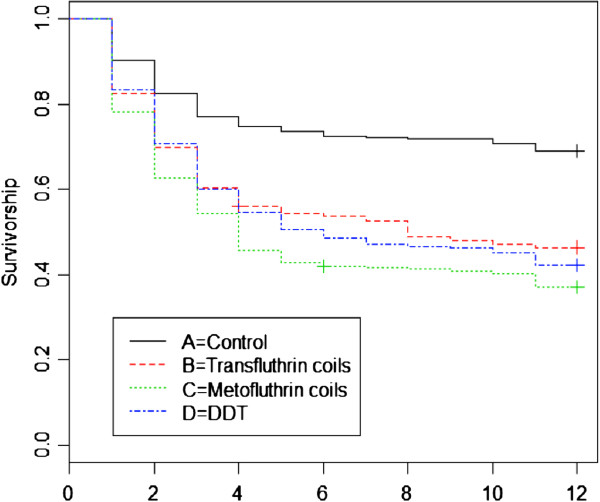
Survival curves illustrating the rate at which mosquitoes left huts with DDT, transfluthrin and metofluthrin coils. The curves represent the rate at which mosquitoes exit huts that have different insecticides compared to the control. Time (hours) to which mosquitoes left huts: 1–2100, 2–2200, 3–2300, 4–0000, 5–0100, 6–0200, 7–0300, 8–0400, 9–0500, 10–0600, 11–0700. Analysis was based on a Kaplan-Meier stepped survivorship function. Each curve represents one treatment.